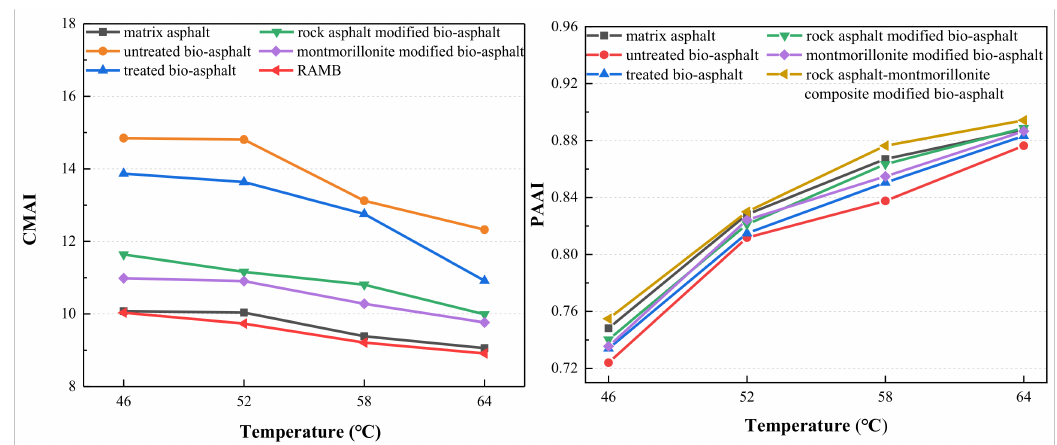
Figure 11. CMAI and PAAI of short-term aging of six asphalts.